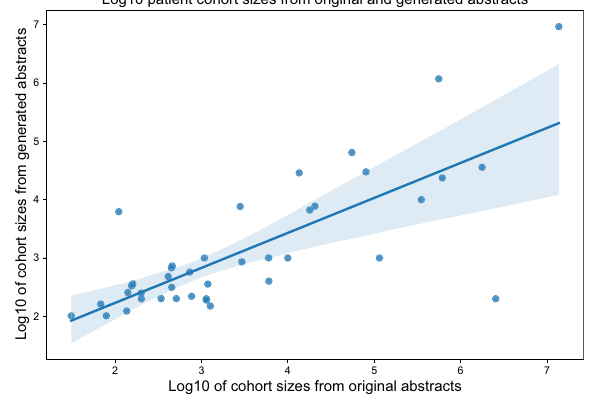
Fig. 1 Generated abstracts have a similar patient cohort size as original abstracts. Cohort sizes from original abstracts ( x -axis) and generated abstracts ( y -axis) plotted on a logarithmic 10 scale.